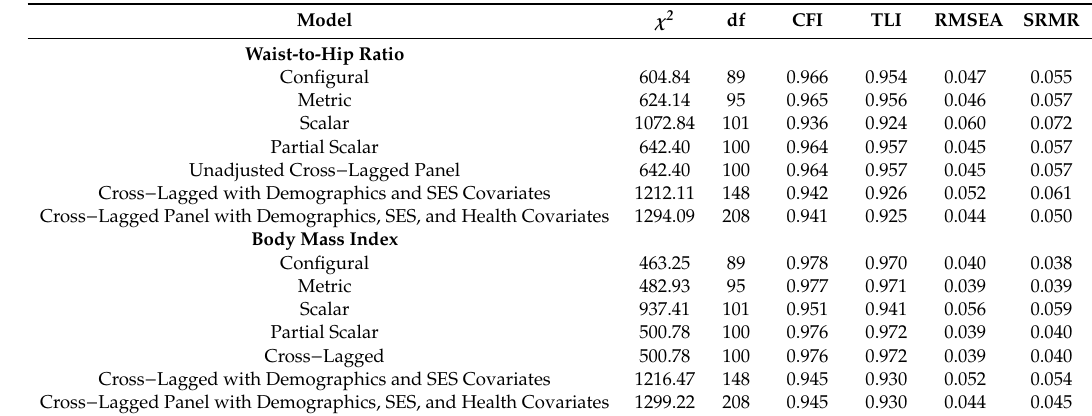
Table 4. Measurement invariance fit indices in waist-to-hip ratio and BMI across two waves with cognitive function as a single latent